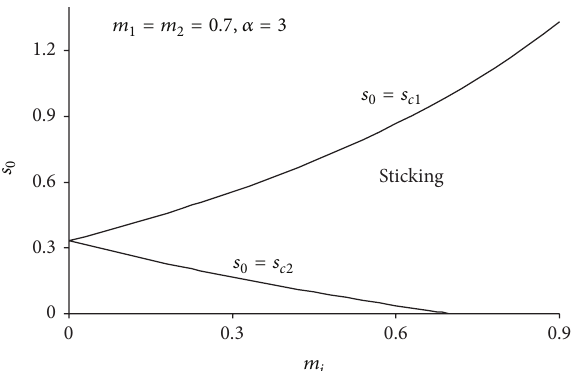
Figure 4: Domain of sticking at the initial